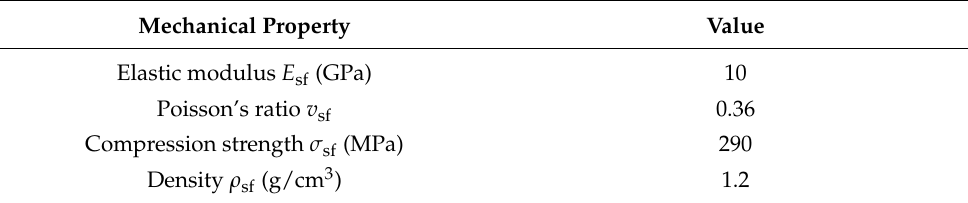
Table 2. Mechanical properties of the short fiber composite material.